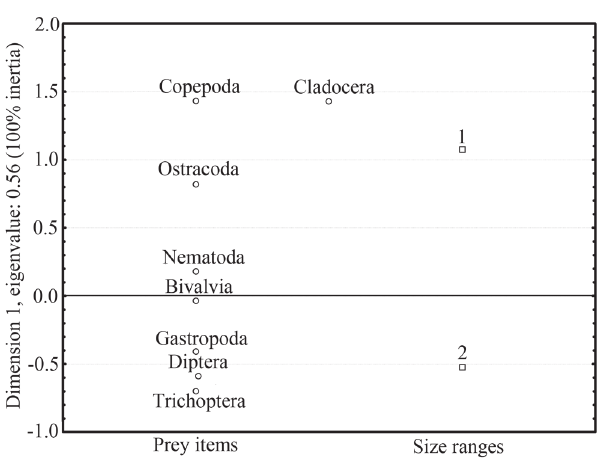
Fig. 3. Correspondence analysis between prey items (circles) and fish size ranges (squares), 1 and 2. Note that the analysis resolved in only one dimension.